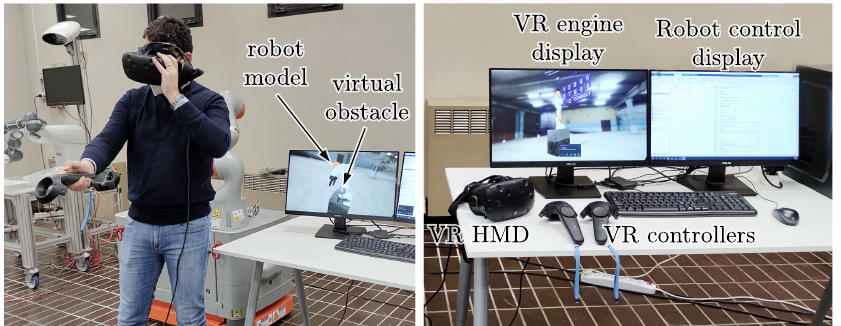
Figure 10. VR system